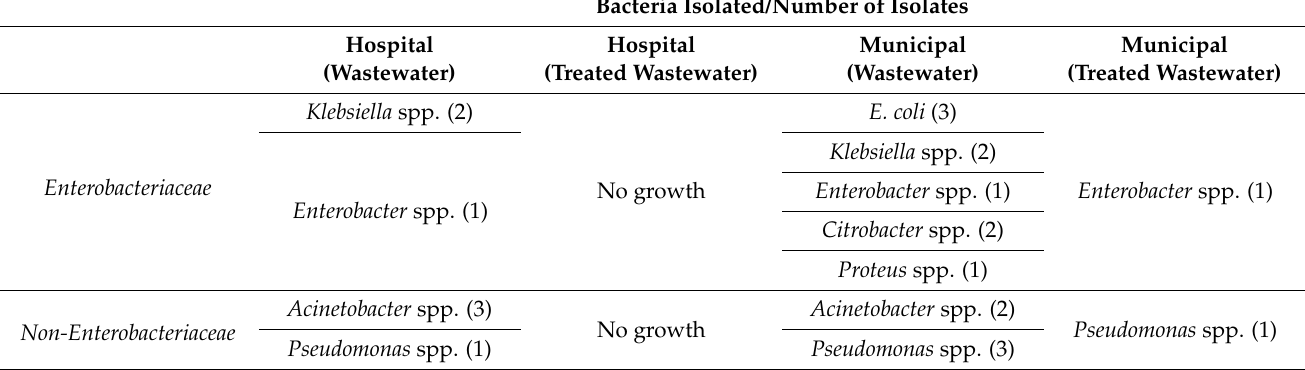
Table 1. List of bacteria isolated. Bacteria Isolated/Number of